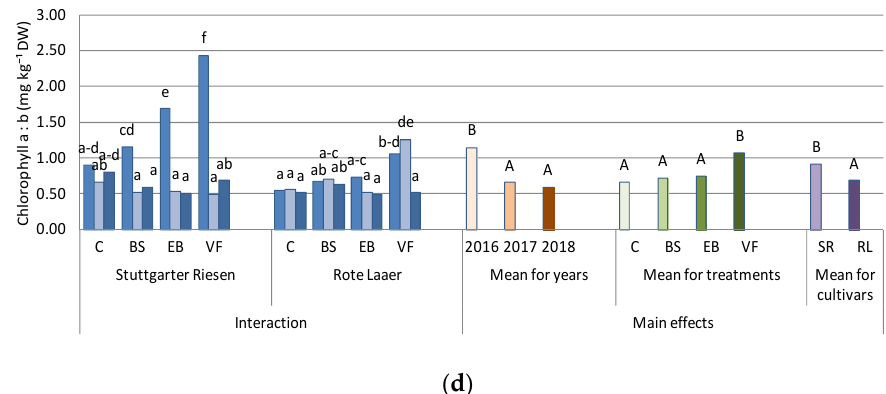
Figure 2. Chlorophyll a ( a ) and b ( b ) content, sum of chlorophylls ( c ) and chl. a:b ratio ( d ) depending on the cultivar, treatments, and years of investigation. The data are the mean values of four replications. Different letters denote significant differences: lowercase letters refer to the interaction and capital letters to the main effects (Fisher’s test, p ≤ 0.05). Abbreviations: C—control; BS—B-Stimul; EB—EkoBooster 2;